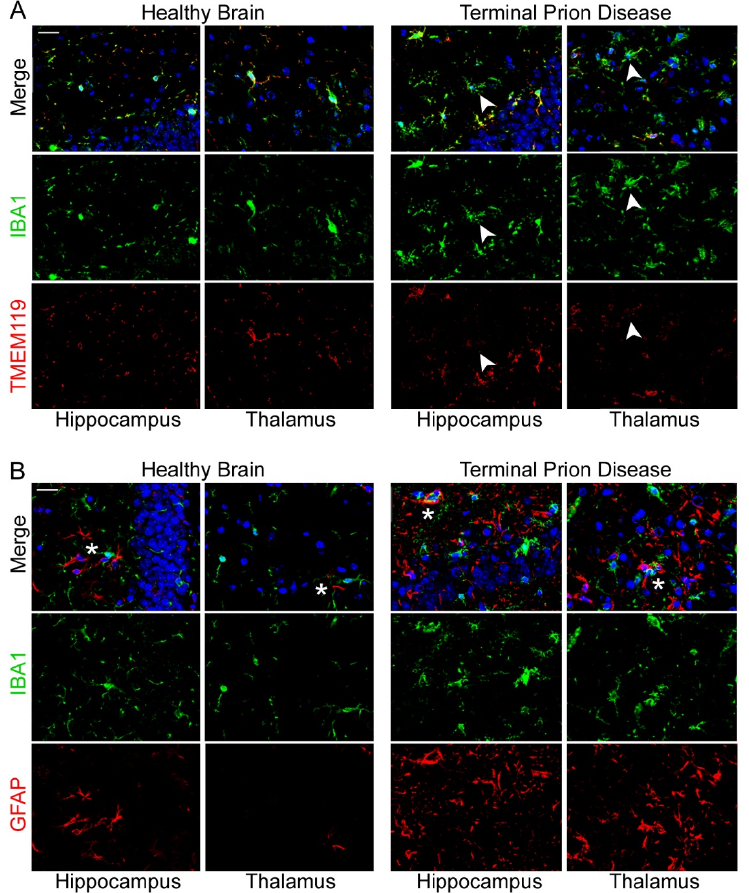
Figure 5. Loss of microglia homeostatic phenotype and increase in gliosis upon terminal prion disease. ( A ) IBA1 (green) and TMEM119 (red) co-localize in the hippocampus and thalamus in the healthy mouse brain, highlighting the ramified morphology with fine processes mainly stained by TMEM119 [47,73,97]. TMEM119 is highly reduced (white arrowhead) in the dentate gyrus of the hippocampus, and completely lost (white arrowhead) in the thalamus (posterior complex) in terminal prion disease [73]. Scale bar: 20 µ m. ( B ) IBA1 (microglia/green) and GFAP (astrocytes/red) show intense dysregulation and are in close proximity (white asterisks) in the healthy brain and in terminal prion disease. (DAPI/nucleus in blue) [73]. Scale bar: 20 µ